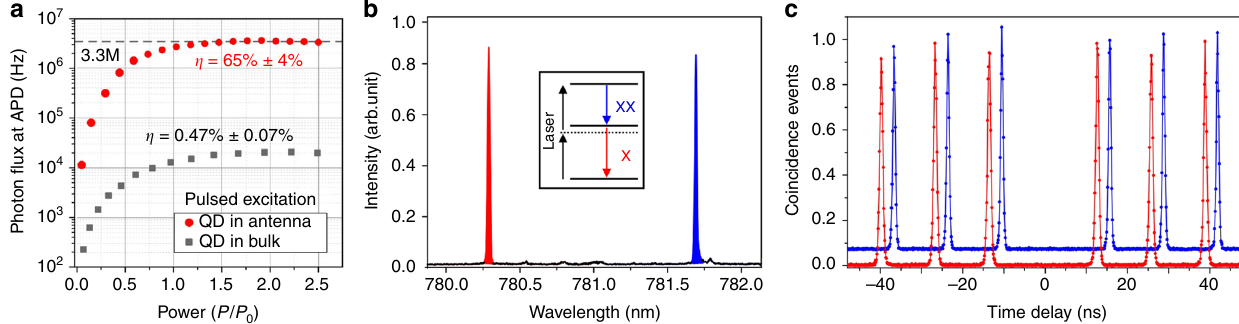
Fig. 2 Characterization of the broadband dielectric antenna and resonant excitation of XX state under 76 MHz pulsed excitation. a Single photon fl ux measured on APD, plotted as a function of laser excitation power (in saturation units), for a QD in dielectric antenna (red dot symbol) and in unprocessed bulk substrate (gray square symbol). At saturation, 3.3 million of single photons per second are detected. b Resonant excitation of the XX state using a two-photon pump scheme. The residual laser signal is strongly suppressed by the setup. c Intensity-correlation histogram from the X transition under two photon pumping excitation. Nearly ideal single-photon emissions is demonstrated by the vanishing multi-photon events at zero time delay g 2 ð 0 Þ ffi 0 : 002 for both X and XX